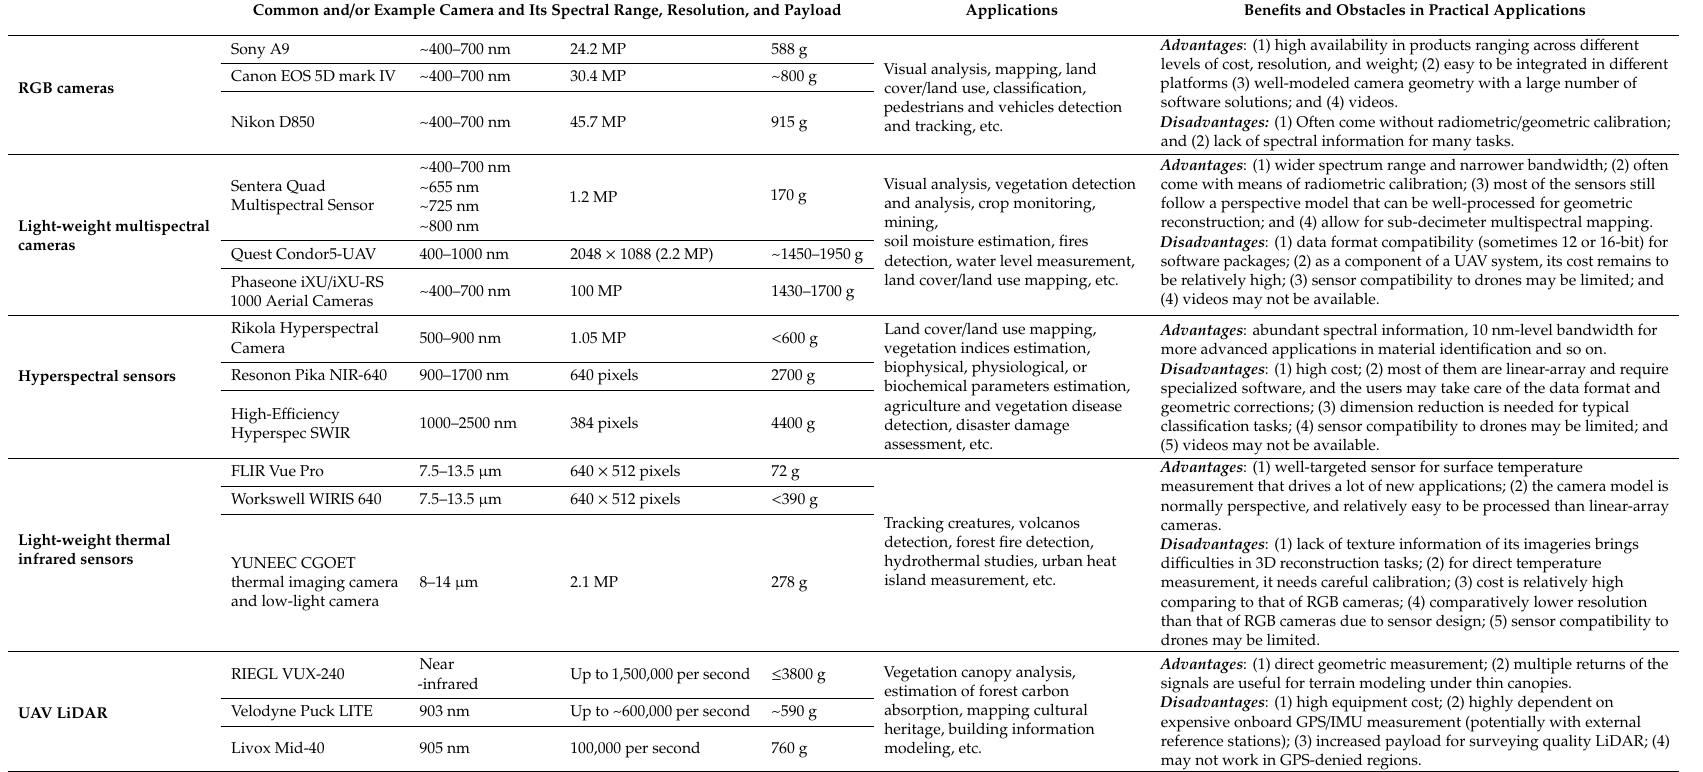
Table 1. Overview of unmanned aerial vehicle (UAV) sensors and examples of these sensors. Common and / or Example Camera and Its Spectral Range, Resolution, and Payload Applications Benefits and Obstacles in Practical